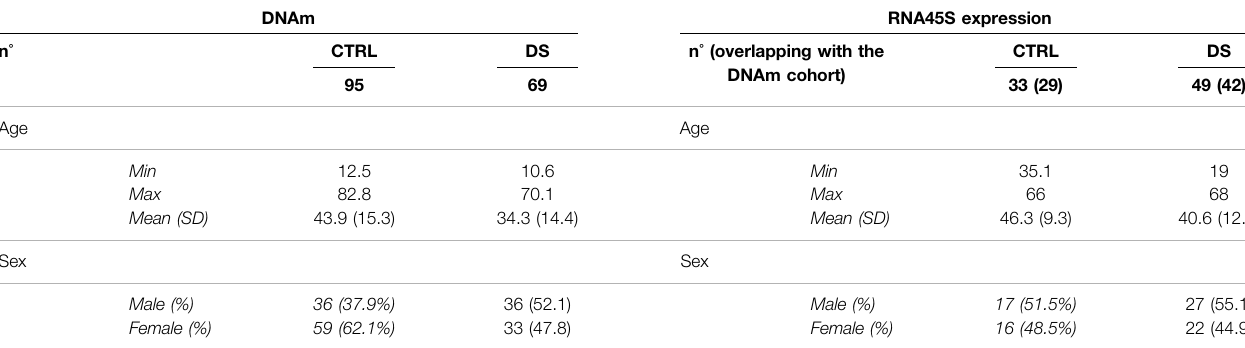
TABLE 1 | Characteristics of the cohort. DNAm RNA45S expression